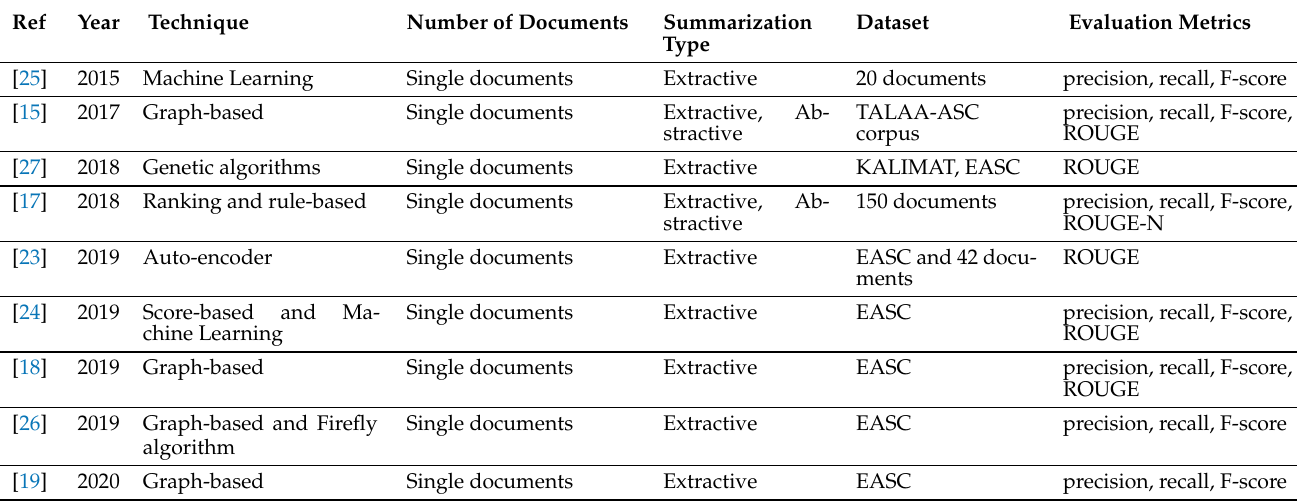
Table 1. Recently proposed Arabic text summarization